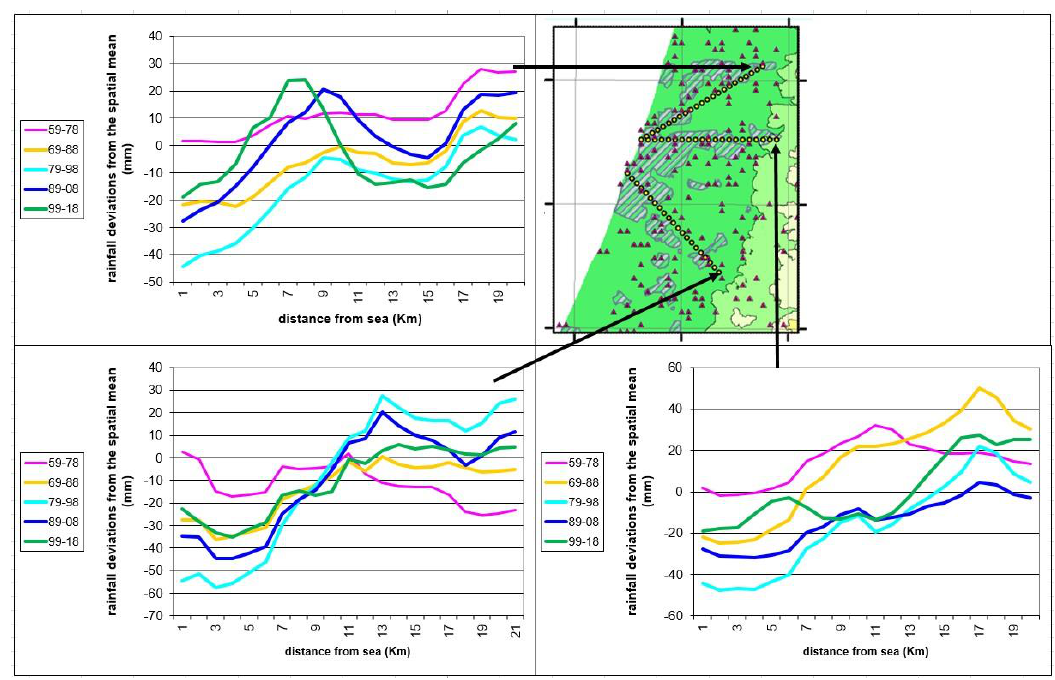
Figure 5. Three geographic lines (or rays) pointing over the greater Tel-Aviv urban area expansion and the corresponding precipitation anomalies for the five chosen 20-year sub-periods, i.e., 1959 – 1978, 1969 – 1988, 1979 – 1998, 1989 – 2008, and 1999 – 2018. Upper-right panel urban areas and stations (in triangles) correspond to the most-recent sub-period of 1999 – 2018. The urban shading is added here with inclined lines and shading (same as the black areas in Figure 4) is shown as well as the